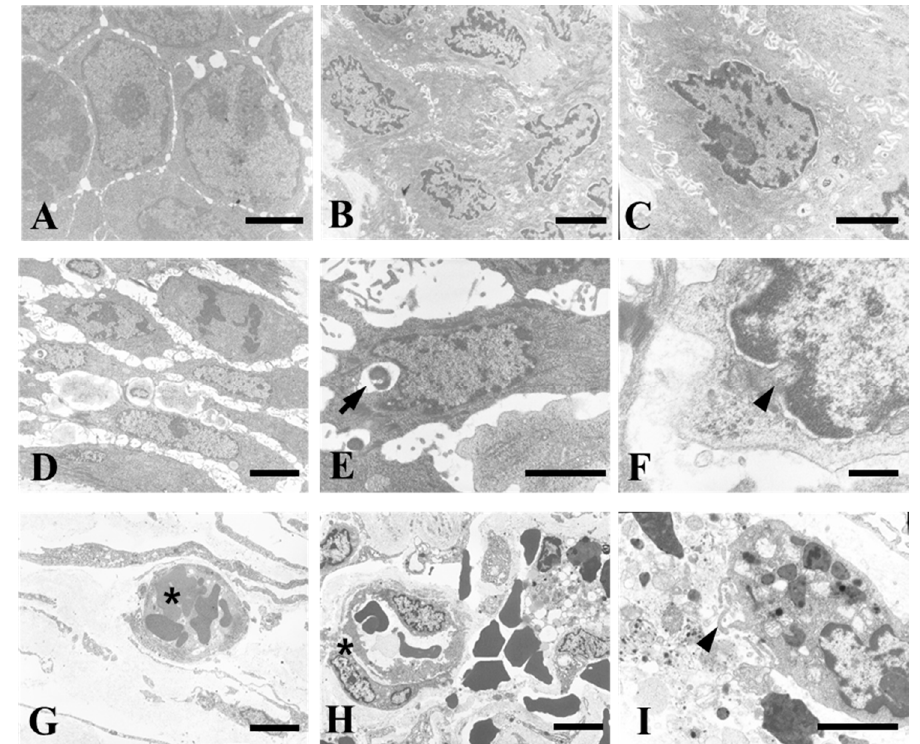
Figure 3. The wireless-powered source induced an inflammatory response and increased the number of immune cells in the surrounding tissue. ( A ) Normal tissues; ( B , C ) groups with sensor only; ( D – I ) wireless power transmission and sensor operational group (arrow, phagocytosis ( E ); arrowhead, destruction of the nuclear membrane ( F ) and cell membrane ( I ); asterisk, vascular endothelial cells ( H )). scale bar = 10 μ m ( A – E , G – I ) and 2 μ m ( F ).